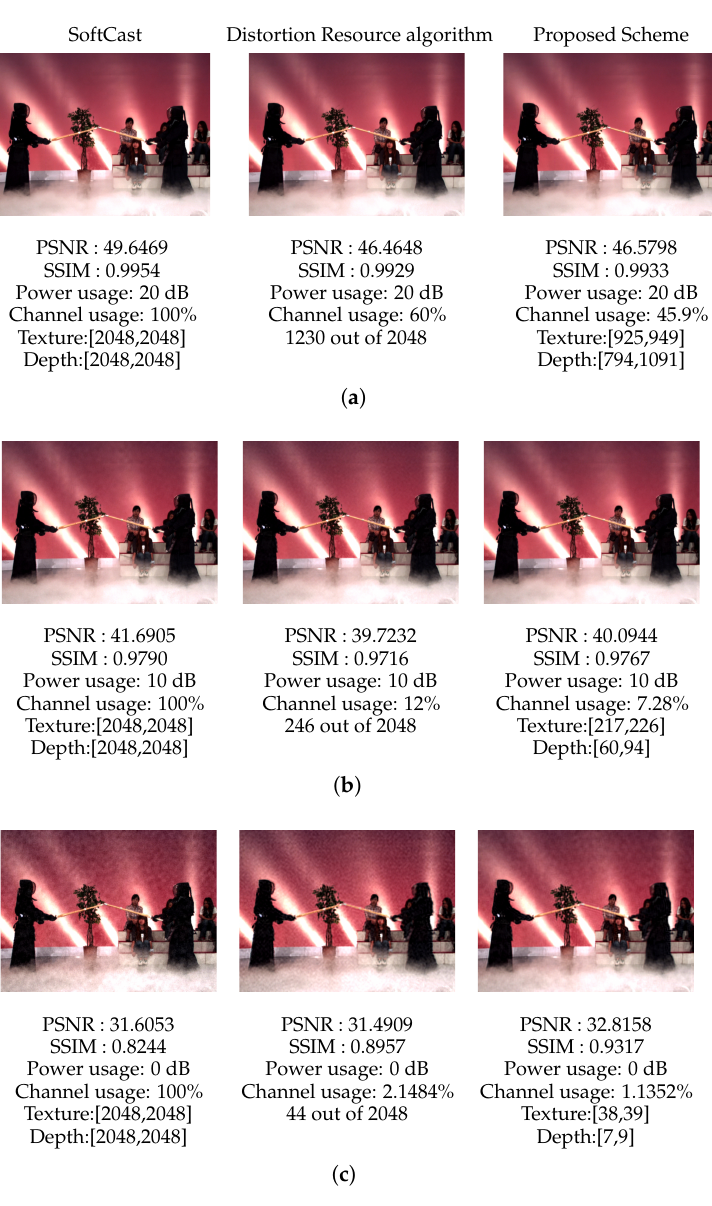
Figure 9. Synthesis quality at virtual view point 2 for different algorithms: ( a ) SNR = 20 dB; ( b ) SNR = 10 dB; ( c ) SNR = 0